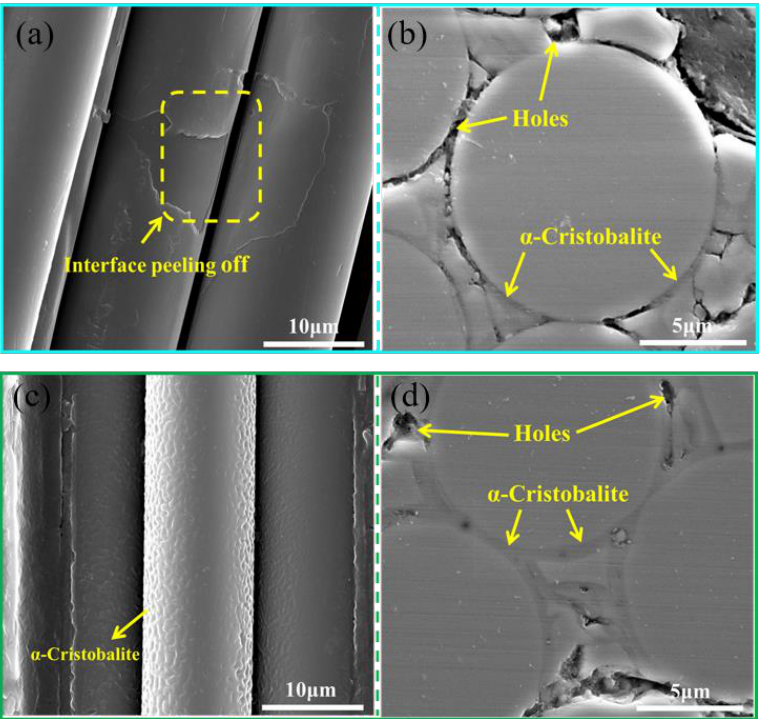
Figure 5. Microstructure morphologies of the 2.5D SiC f /SiC m composites under different treatment conditions. ( a , b ) A-800, ( c , d ) A-1400.